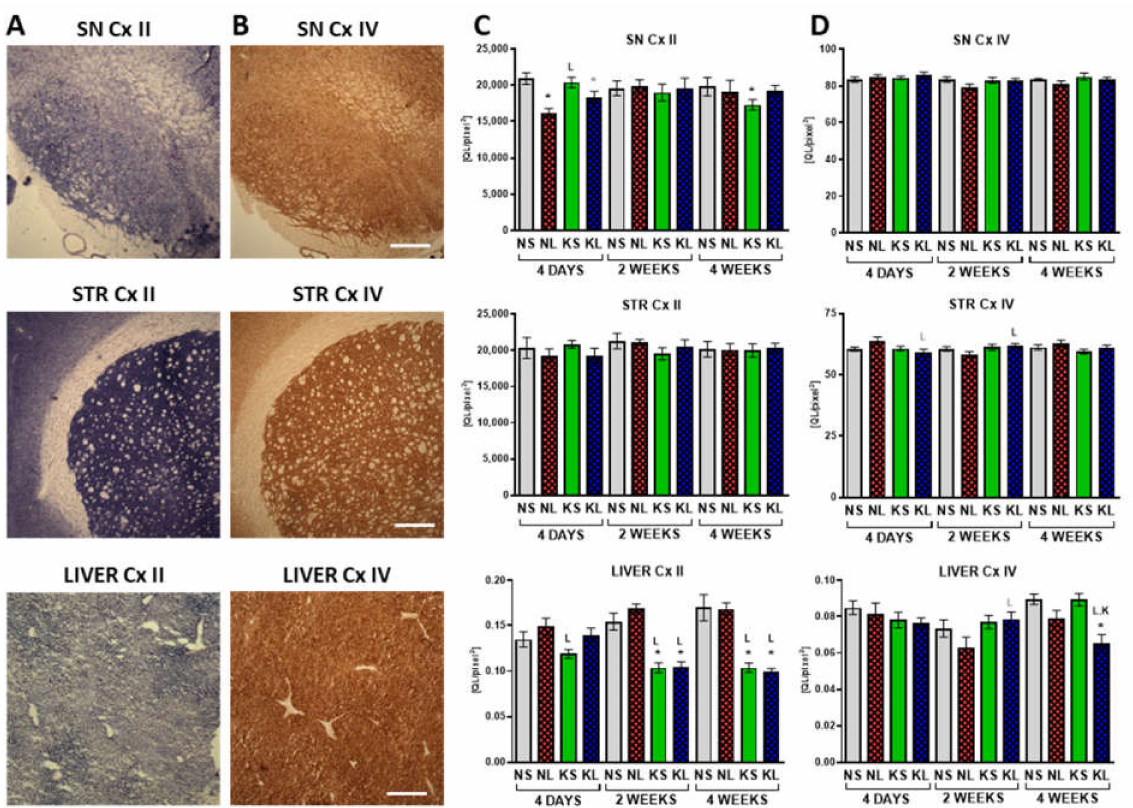
Figure 7. Cx II ( A , C ) and Cx IV ( B , D ) staining in brain and liver, representative photographs ( A , B ) and quantification ( C , D ). Staining was performed on tissue sections from SN and STR and liver as Relative Optical Density (ROD). Data are presented as mean ± SEM. Analysis was performed at time-points 4 days, 2 weeks, and 4 weeks after brain surgery. Animals were kept on ketogenic diet for 3 weeks in advance. p value ≤ 0.05 was set as significance threshold and marked as * vs. normal diet + sham (NS group), L vs. normal diet + 6-OHDA lesion (NL group), K vs. ketogenic diet + sham (KS group), KL stands for ketogenic diet + 6-OHDA lesion group. Statistical trends 0.05 < p ≤ 0.1 were marked in grey symbols. Statistics: 3-way ANOVA with LSD post hoc test. Number of animals was 5–7 per group. Scale bar represents 400 µ